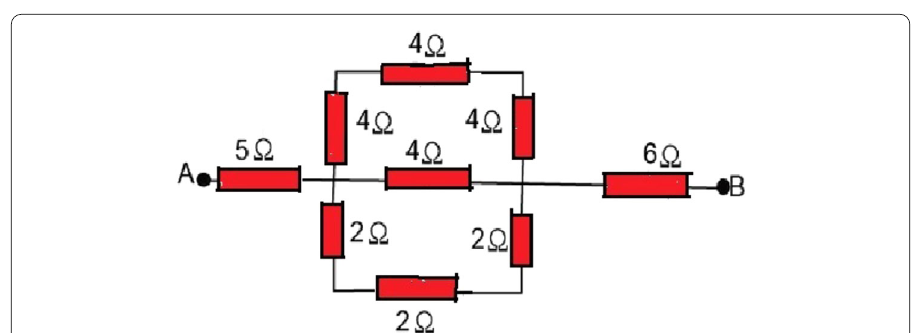
Figure 7 Parallel and series